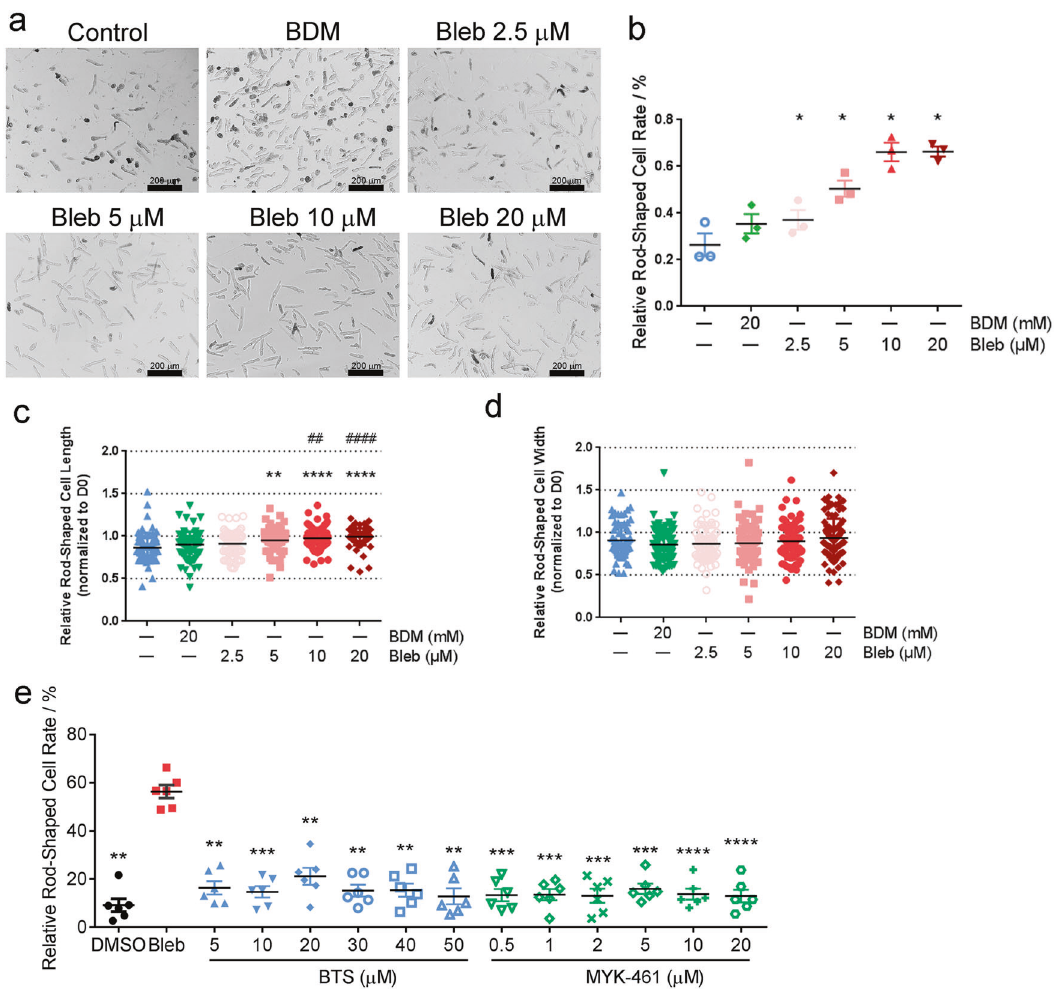
Fig. 3 Blebbistatin improves hPCM culture. a Live-cell imaging (D5) of hPCMs cultured with different concentrations of Bleb. Images are representative of three independent experiments. b Quanti fi cation of the relative percentage of rod-shaped cells in a . c , d Tracking of cell length ( c ) and cell width ( d ) changes by D5, normalized to D0. e Comparison of the effect of Bleb with two other myosin inhibitors, BTS and MYK-461 (D7). Data were mean ± SEM ( b , e ) or mean ± SD ( c , d ), statistical signi fi cance was calculated by one-way repeated measures